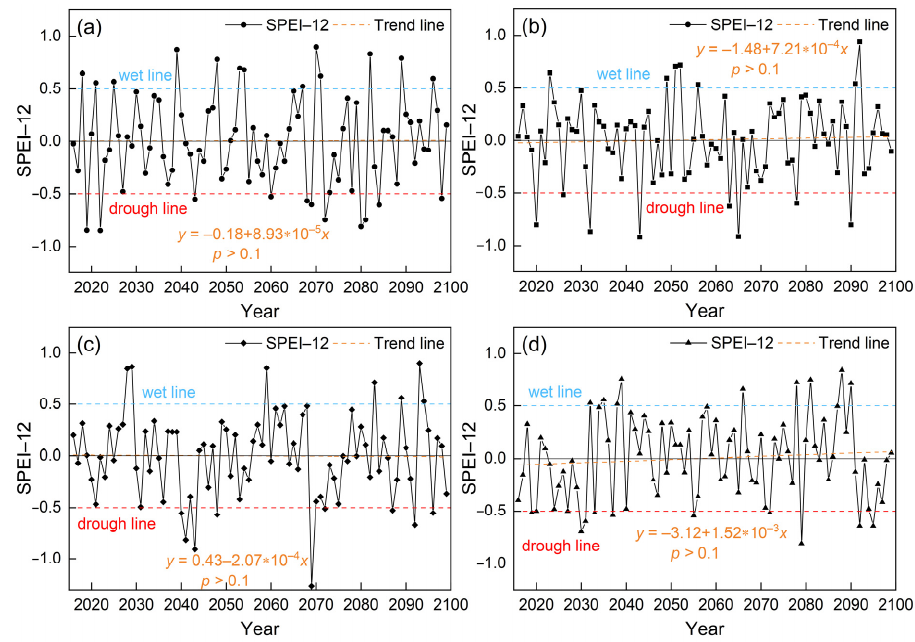
Figure 5. Temporal variation of SPEI-12 in the TP from 2016 to 2099 under the ( a ) RCP2.6, ( b ) RCP4.5, ( c ) RCP6.0, and ( d ) RCP8.5 climate scenarios.